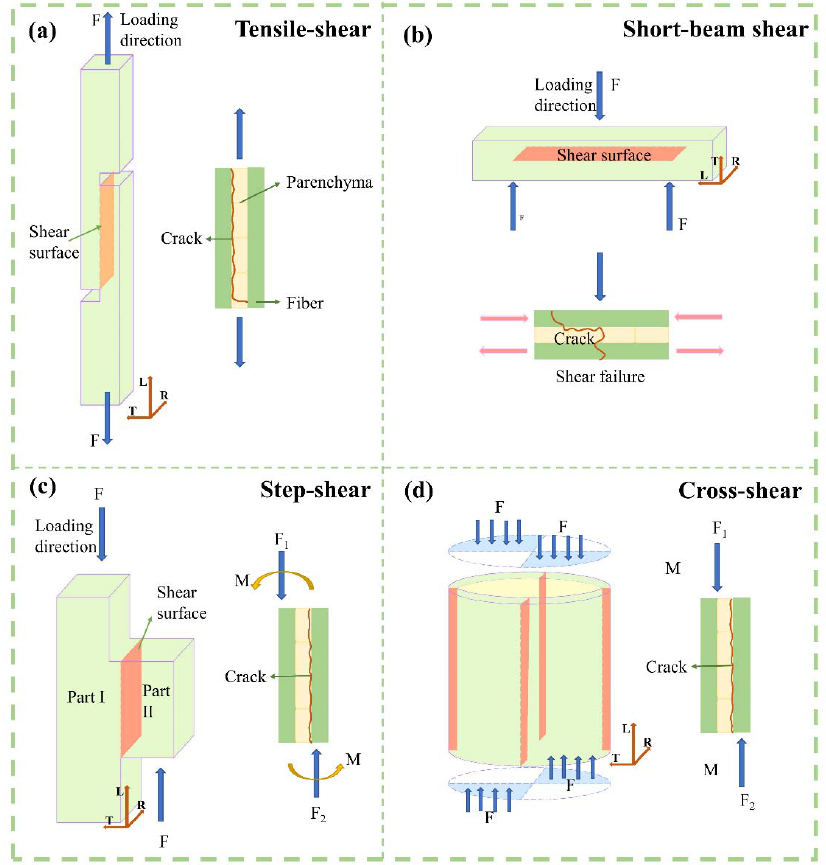
Figure 2. Loading modes of four test methods. ( a ) Tensile-shear test, ( b ) short-beam-shear test, ( c ) step-shear test, ( d ) cross-shear test.